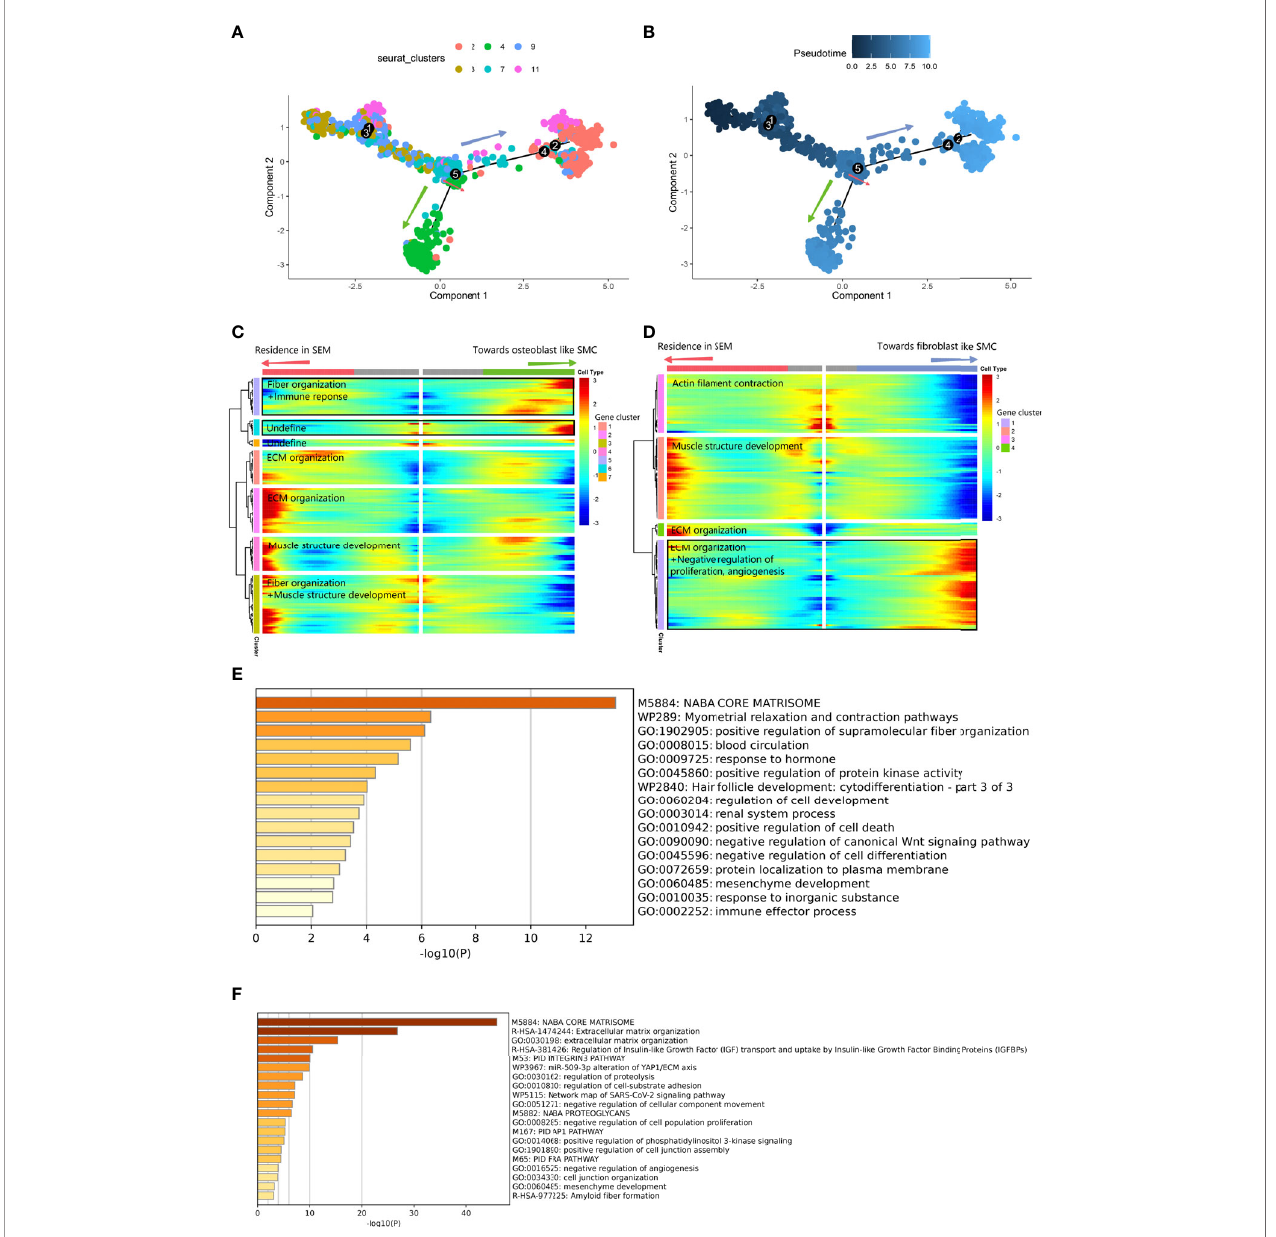
FIGURE 6 | Differentiated trajectory of vascular SMC lineage cells. (A, B) Scatter plot showing the pseudotime trajectory in the vascular SMC lineage. (A) is colored with cell clusters, and (B) is colored with pseudotime orders. The green arrow indicates the transition toward osteoblast-like SMCs. The blue arrow indicates the transition toward fi broblast-like SMCs. (C, D). Heatmap plot showing gene expression alterations along the branch at node 5 toward osteoblast-like SMCs (C) and toward fi broblast-like SMCs (D) on the pseudotime trajectory tree. Red indicates high expression, and blue indicates low expression. The black box shows the highly expressed gene cluster in osteoblast-like and fi broblast-like SMCs. (E) Bar plot for the top-ranked gene set enrichment in the high expression gene cluster in the osteoblast-like SMC branch at node 5. (F) Bar plot for the top-ranked gene set enrichment in the high expression gene cluster in the fi broblast-like SMC branch at node osteoporotic and atherosclerotic circulating monocyte mRNA datasets. First, based on their markers, the CD14 + monocyte cluster was annotated as CD14 + CD16 - G1 classic monocytes.